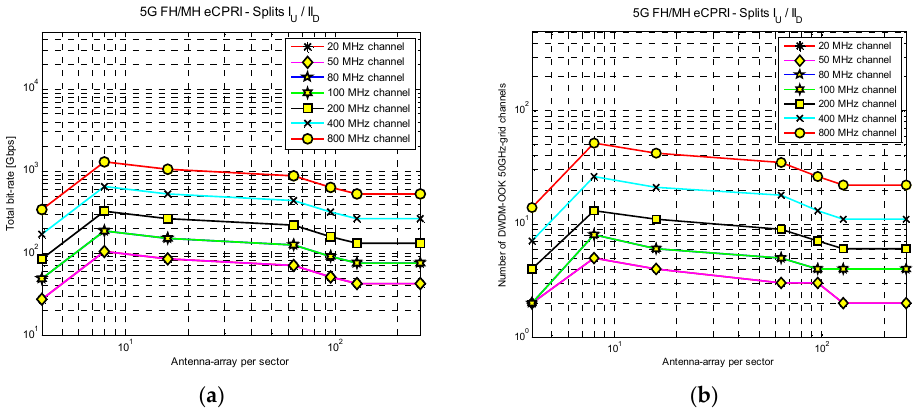
Figure 11. Calculation results of optical resources needed to connect 4-sector gNB-DU/RRH to optical fronthaul/midhaul as a function of antenna elements number of massive-MIMO array (calculation parameters changing according to Tables 1 and 2)—there are overlapping lines in graphs for 20 MHz and 50 MHz, as well as 80 MHz and 100 MHz: ( a ) total bit-rate for radio BB channels digitized to eCPRI format—Splits I U /II D (Figure 7c); ( b ) number of DWDM-OOK 50GHz-grid channels for radio BB channels digitized to eCPRI format—Splits I U /II D (Figure 7c).